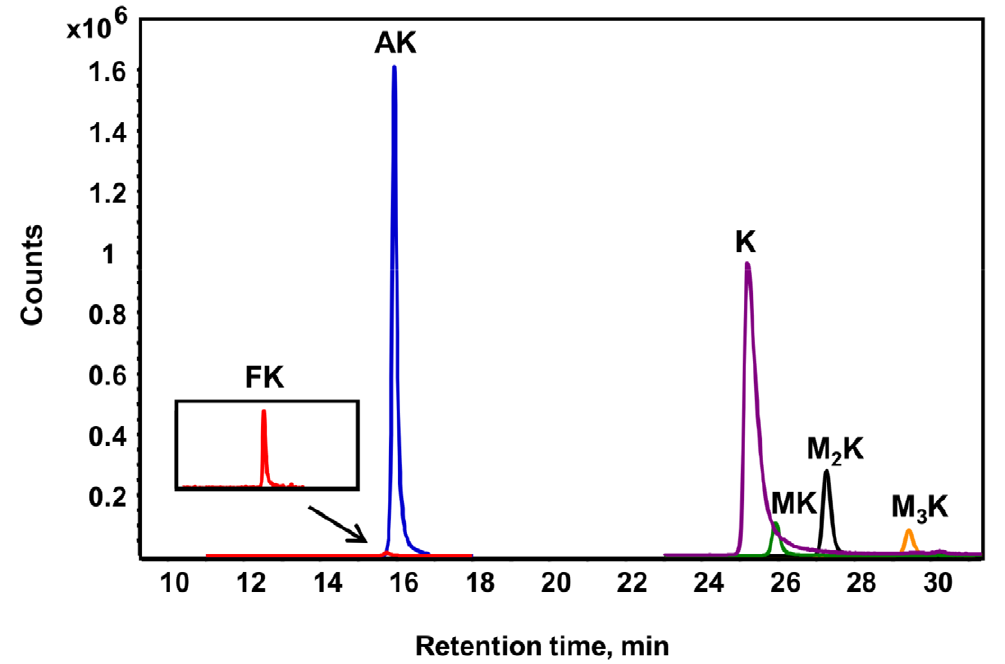
Figure 2. Different lysine species detected in purified histone H4 from TK6 cells. Lysine adducts were monitored by tandem mass spectrometry, as described in Materials and Methods . Abbreviations: FK, N 6 -formyllysine; AK, N 6 -acetyllysine; K, lysine; MK, N 6 -mono-methyllysine; M 2 K, N 6 -di-methyllysine; M 3 K, N 6 -tri-methyllysine.